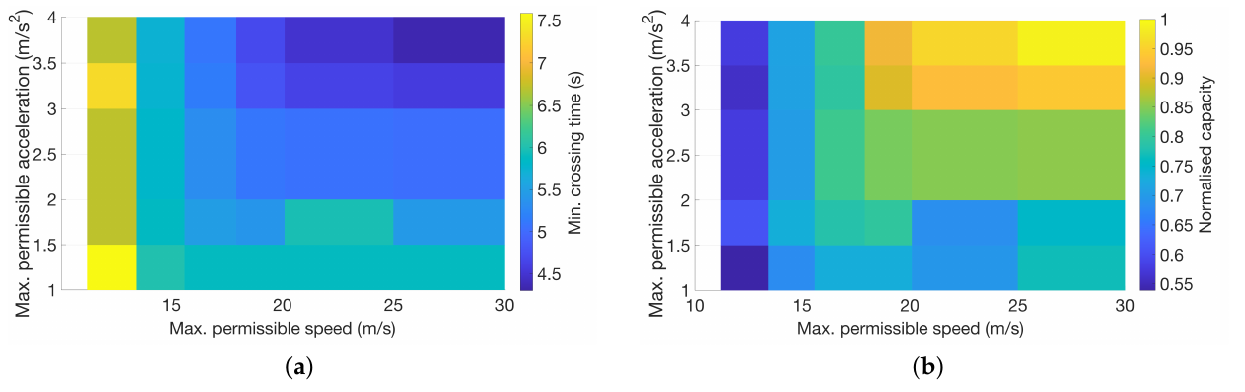
Figure 4. Sensitivity of the ( a ) crossing time and ( b ) capacity of the lane-free intersection in terms of the maximum speed and acceleration of CAVs. Initial speed of the vehicles is 10 (m/s). Figure 5 provides more details on the results of Figure 4. Samples of the results in Figure 4 for two different values of the maximum permissible accelerations and speeds are illustrated separately in Figure 5. As seen, the best crossing time of CAVs and equivalently the maximum capacity of the lane-free intersection improves by 28% due to an increase of the maximum acceleration from 2 (m/s 2 ) to 4 (m/s 2 ), and when CAVs enter the control area of the intersection with the initial speed of 5 (m/s). Figure 5 also shows that, doubling the initial speed from 5 (m/s) to 10 (m/s), the best crossing time and hence the maximum capacity increase by, respectively, 28% and 19% for the maximum accelerations of 2 (m/s 2 ) and 4 (m/s 2 ).